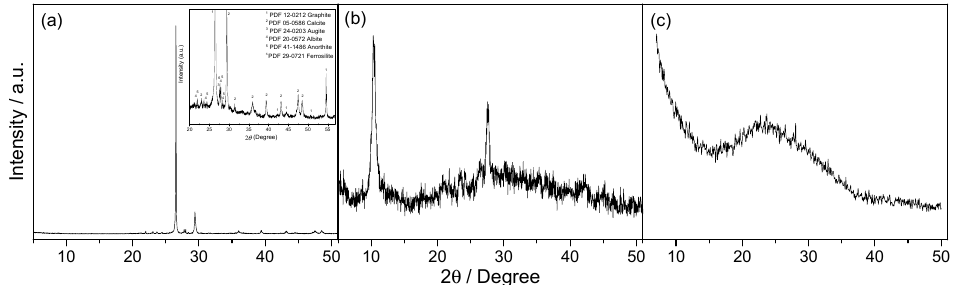
Figure 1. XRD pattern of untreated natural graphite ( a ); the inset shows the zoomed region; graphitic oxide ( b ); and graphene nanosheets ( c ).